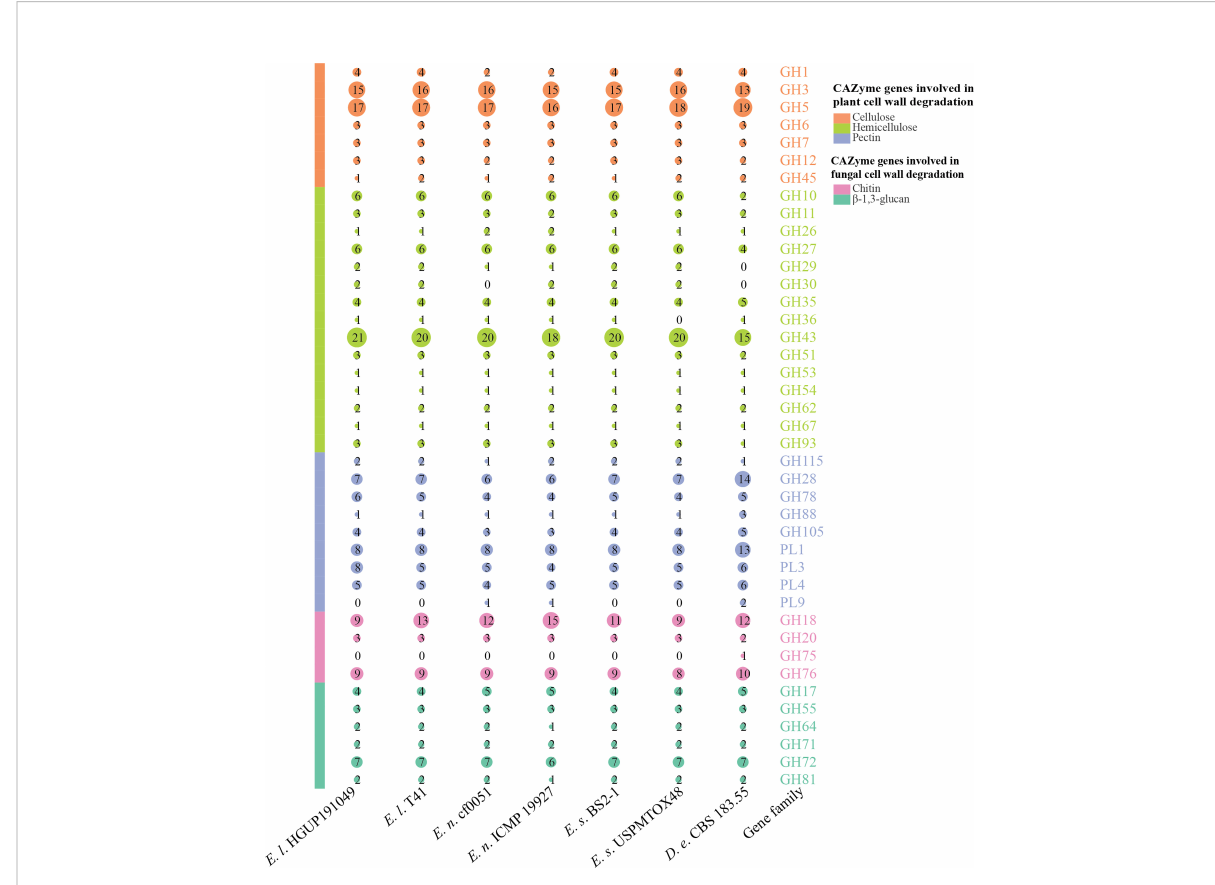
FIGURE 9 Comparisons and annotations of carbohydrate-active enzyme genes. D.e , Didymella exigua ; E.l , Epicoccum latusicollum ; E.n , Epicoccum nigrum ; E.s , Epicoccum sorghinum. Different circle sizes indicate the number of different gene